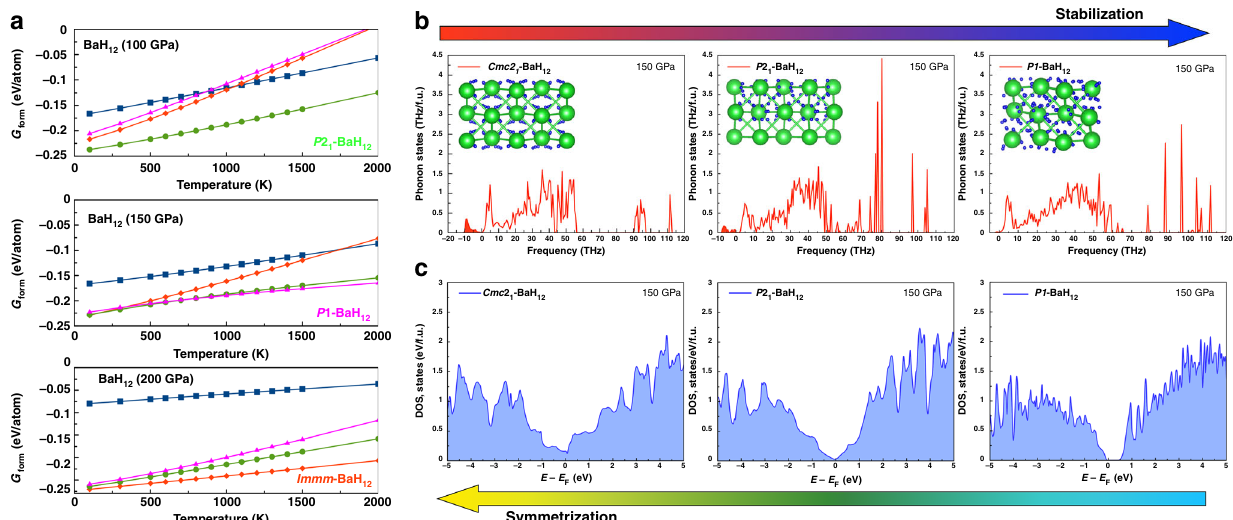
Fig. 2 Theoretical study of stability and electronic properties. a Dependence of the Gibbs free energies of formation on the temperature for